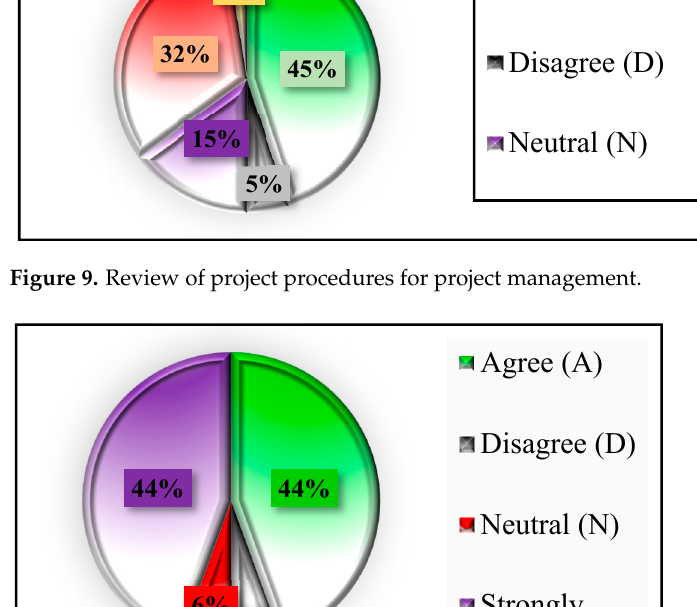
Figure 9. Review of project procedures for project management .